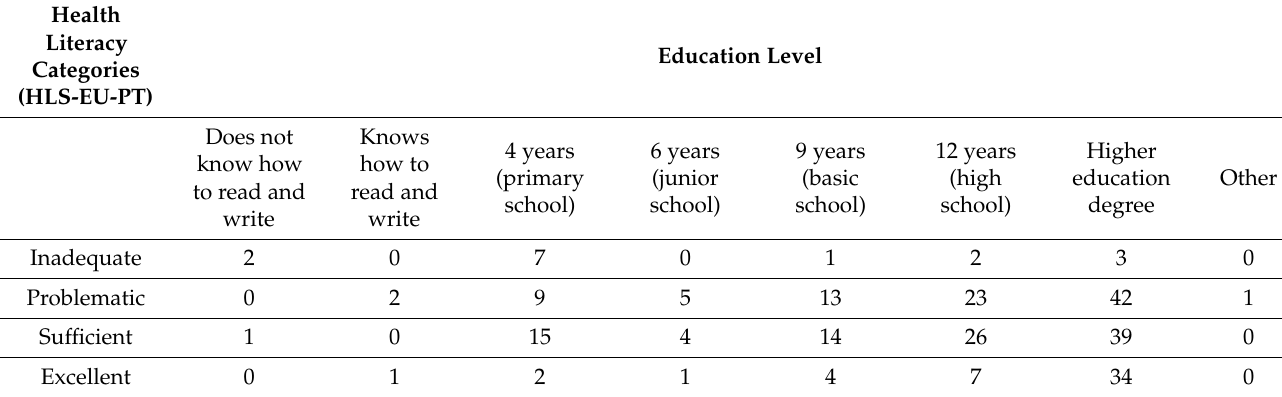
Table 5. Observed frequencies of education level by health literacy categories (valid N =